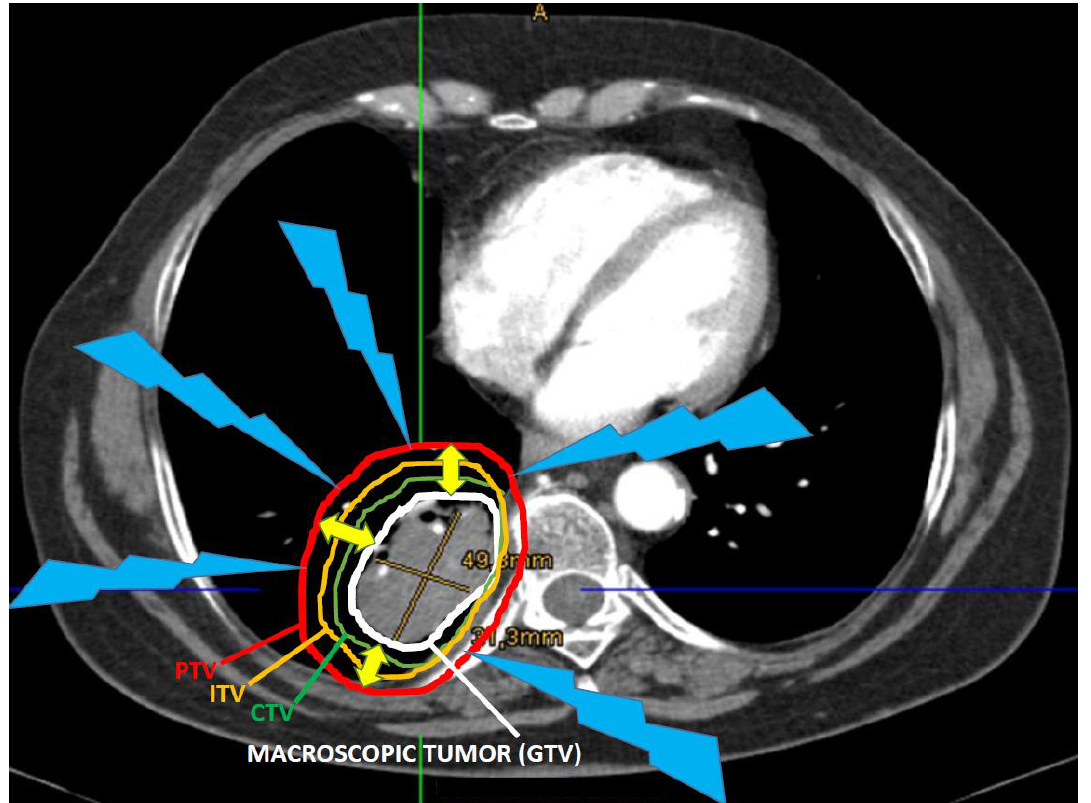
Figure 1. Concept of treating volumes of the conventional RT: the figure shows a centrally located right-side lung tumor (gross tumor volume-GTV, white contour). In order to address the high-risk of subclinical/microscopic disease spread, the clinical target volume (CTV, green contour) is contoured and considered as target for irradiation. Additionally, in order to account for the tumor motion due to respiration, the internal target volume (ITV, orange contour) will also be drawn taking into consideration tumor motion in 4D-CT. Finally, to account for the set-up error(s) related to the patients daily (re)positioning, an additionally larger volume known as the planning target volume (PTV, red contour) is also drawn as the final treating volume for radiation treatment. The yellow arrows indicate the definitive diameter of the final treatment volume in comparison to the macroscopic tumor (GTV). Significant amount of the surrounding peri-tumoral healthy tissue between GTV and PTV will be exposed to the full radiation dose (blue lines), the same that will be delivered to the tumor.